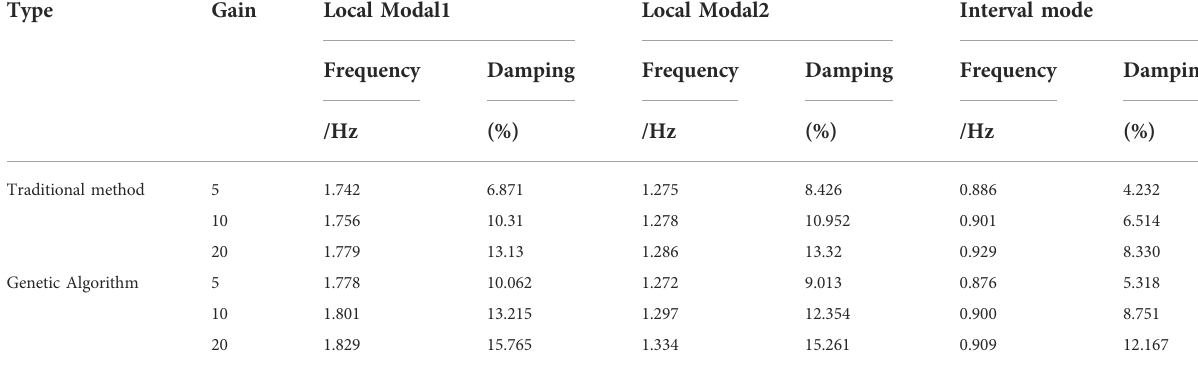
TABLE 3 Damping characteristics of system oscillation modes after installing two different controllers.